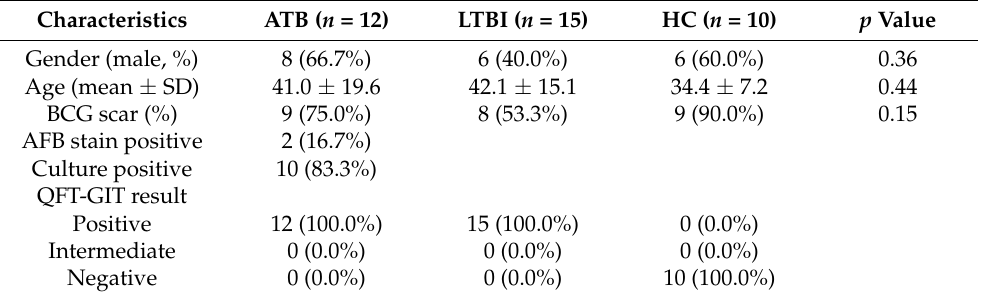
Table 1. Demographic and clinical characteristics of patients with active tuberculosis, individuals with latent tuberculosis infection, and healthy controls.